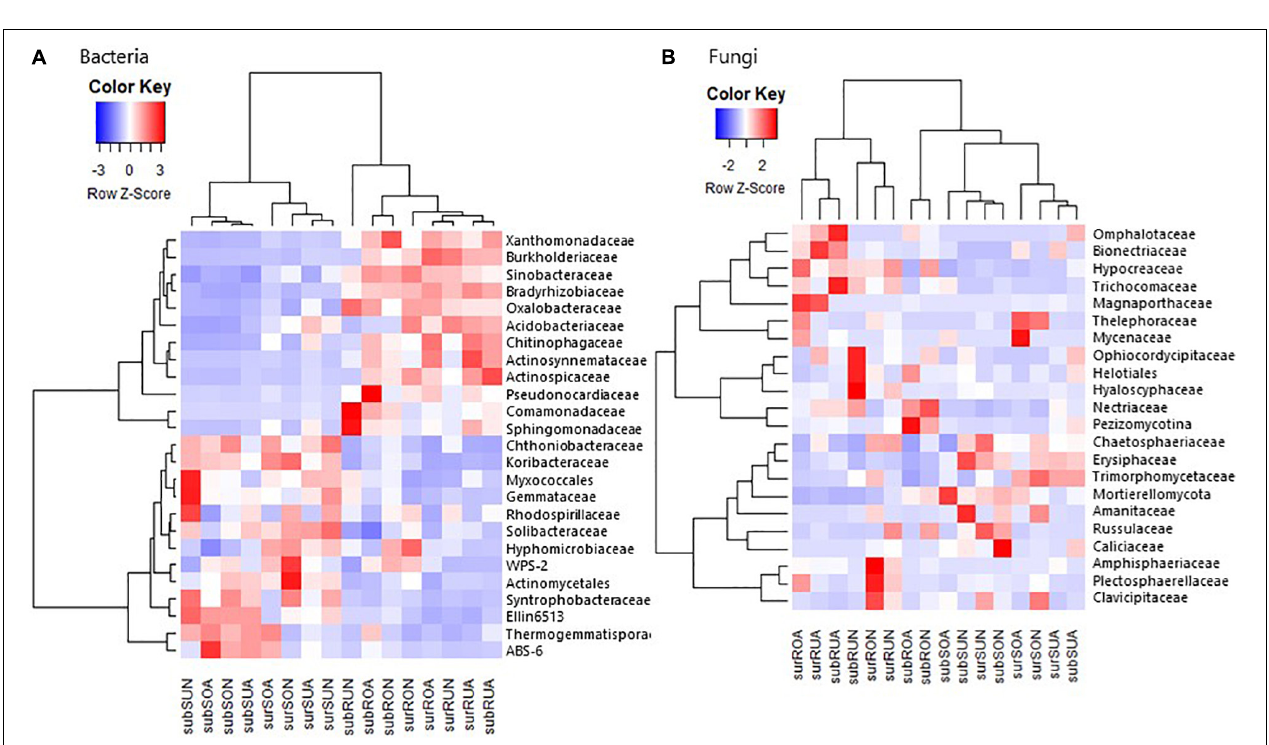
FIGURE 3 | A heat map for the hierarchical clustering of (A) bacterial and (B) fungal average relative abundances at family level, Taxa with more than 1% of the abundance are represented. Relative abundance of each taxon was transformed into a row Z-score, and darker red and blue indicate higher and lower abundances, respectively, sur, sub, R, S, O, U, A, and N in x axis indicate surface, subsurface, Root, Soil, Oxisols, Ultisols, Acacia, and Native, respectively.